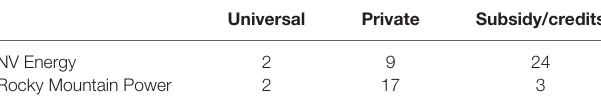
taBle 1 | Frequency of use of each key term from The Future of Energy on utility company